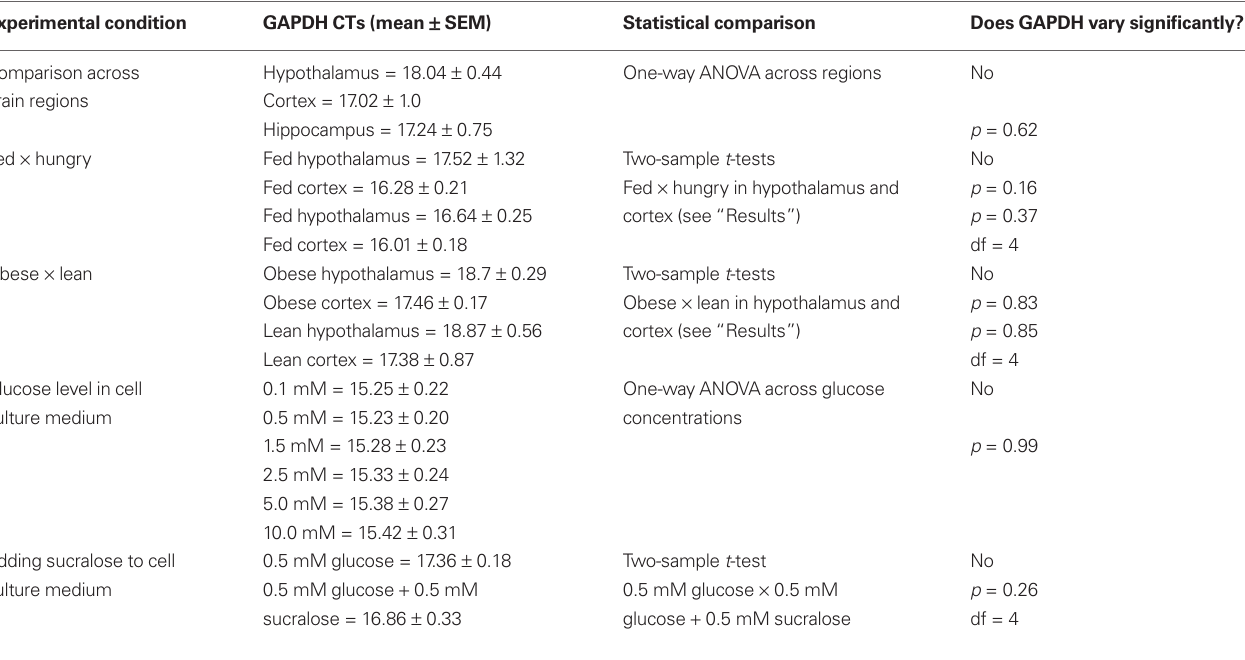
Table 2 | C values for GAPDH under the different experimental T